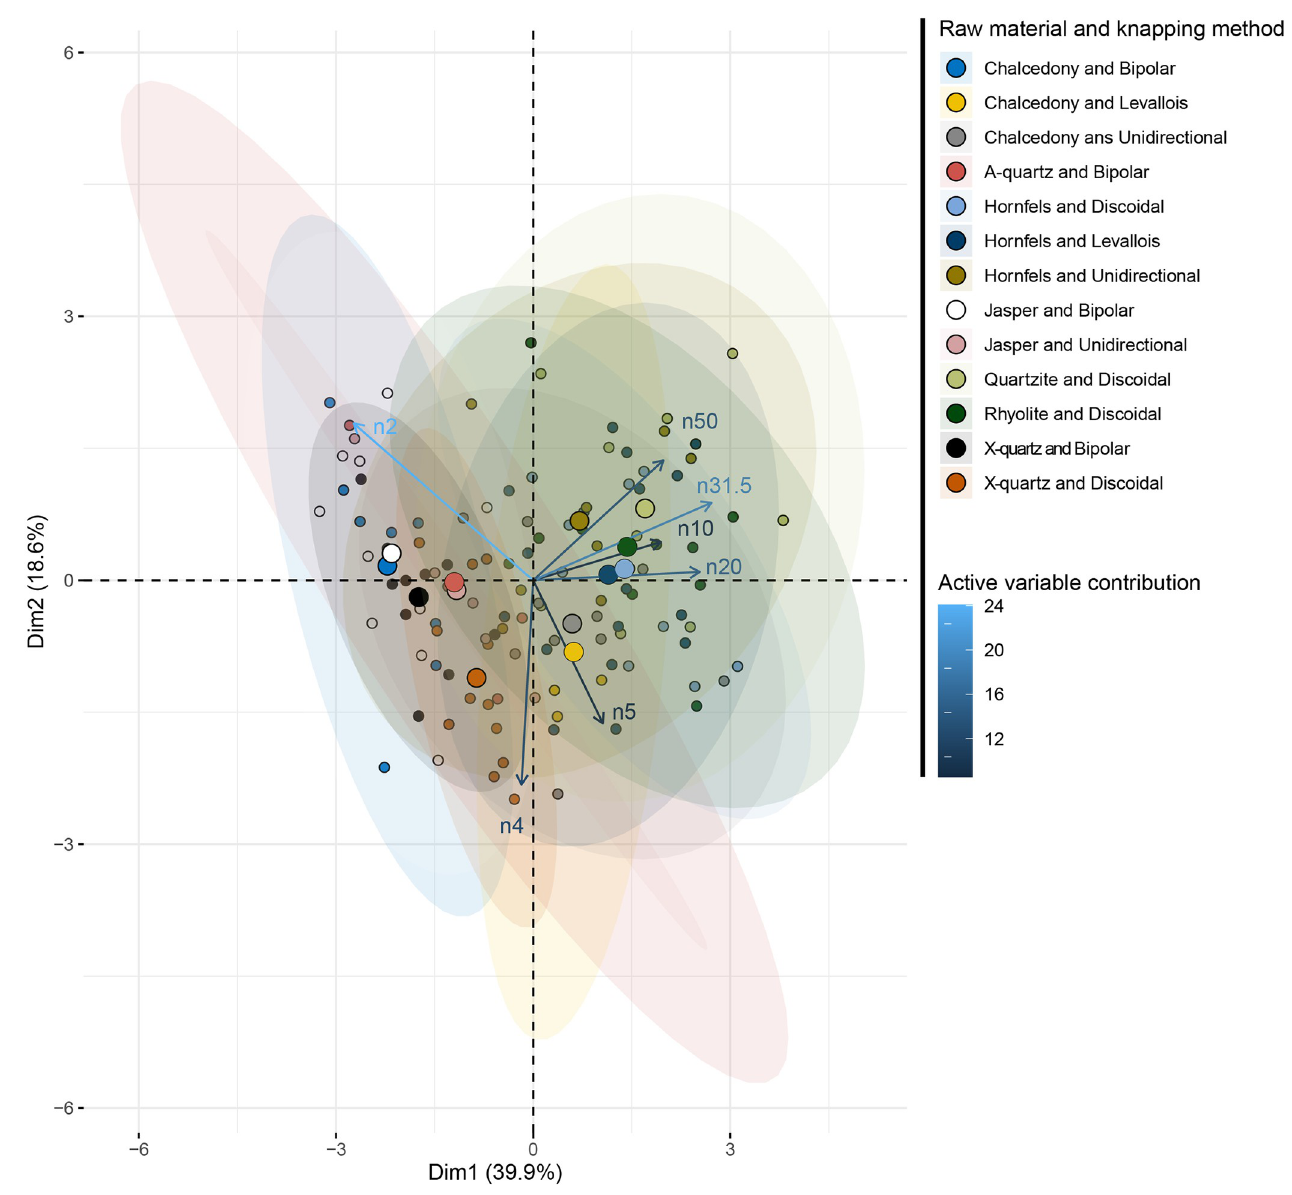
Fig 12. PCA combining knapping and raw material as a supplementary variable (SA